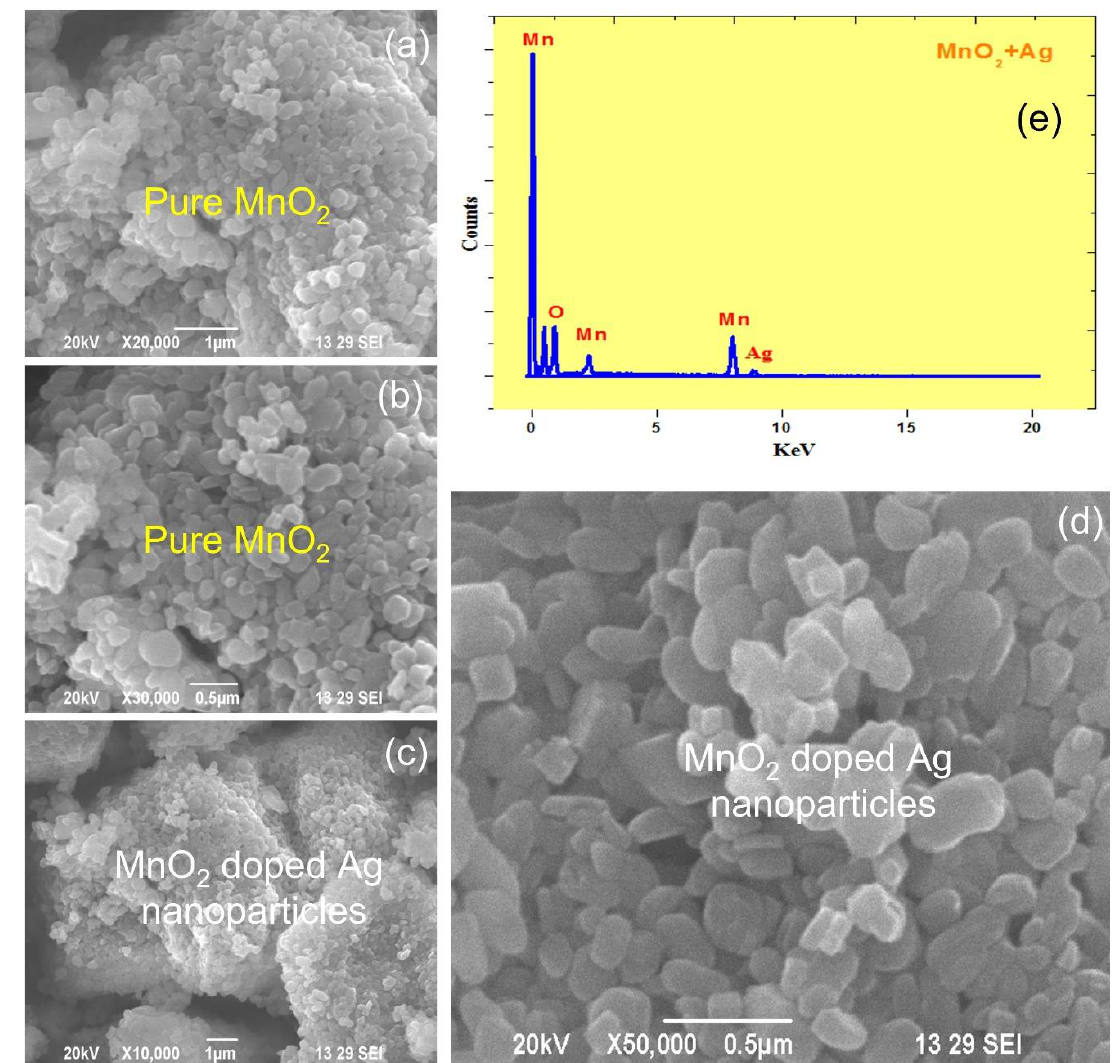
Figure 5. (a – e) Scanning electron microscopy images of ( a – b ) pure MnO 2 ; ( c – d ) MnO 2 doped with Ag nanoparticles; and EDX spectrum ( e ).